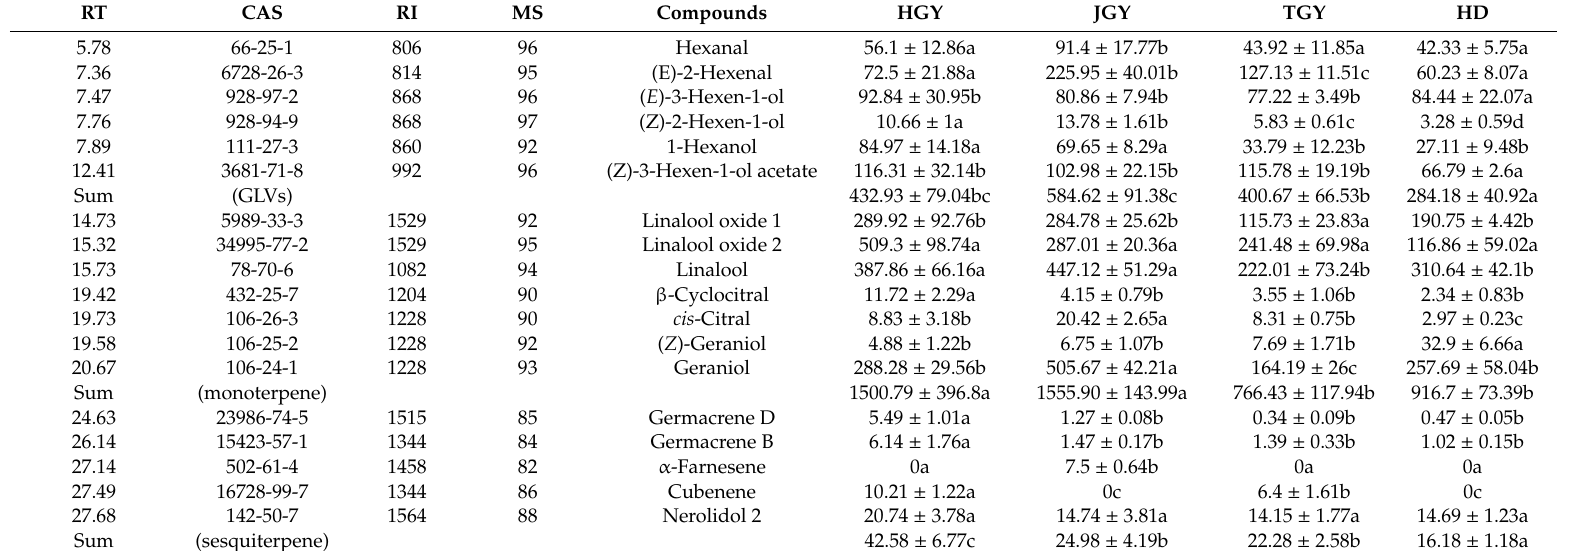
Table 1. Volatiles content of F1 hybrids and their parents (HD × TGY) (ng /